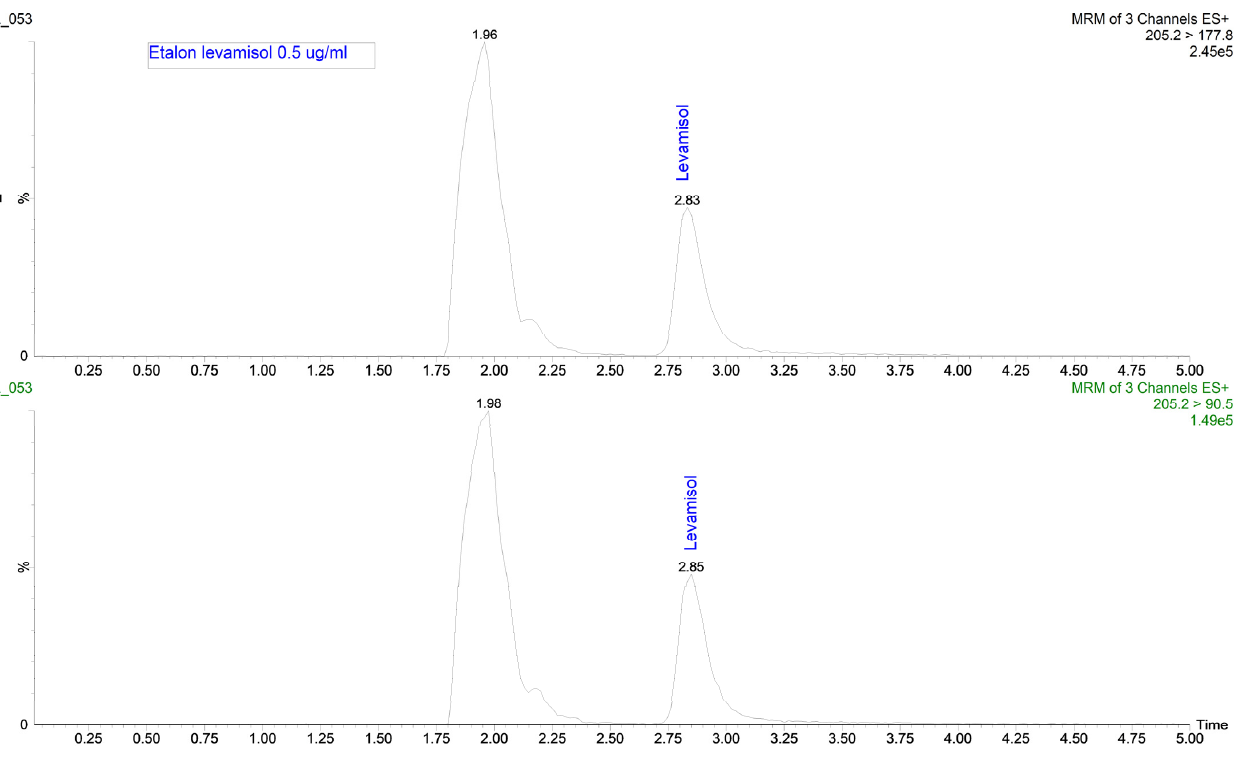
Figure A1. Chromatogram of standard levamisole solution 0.5 μ g/mL.